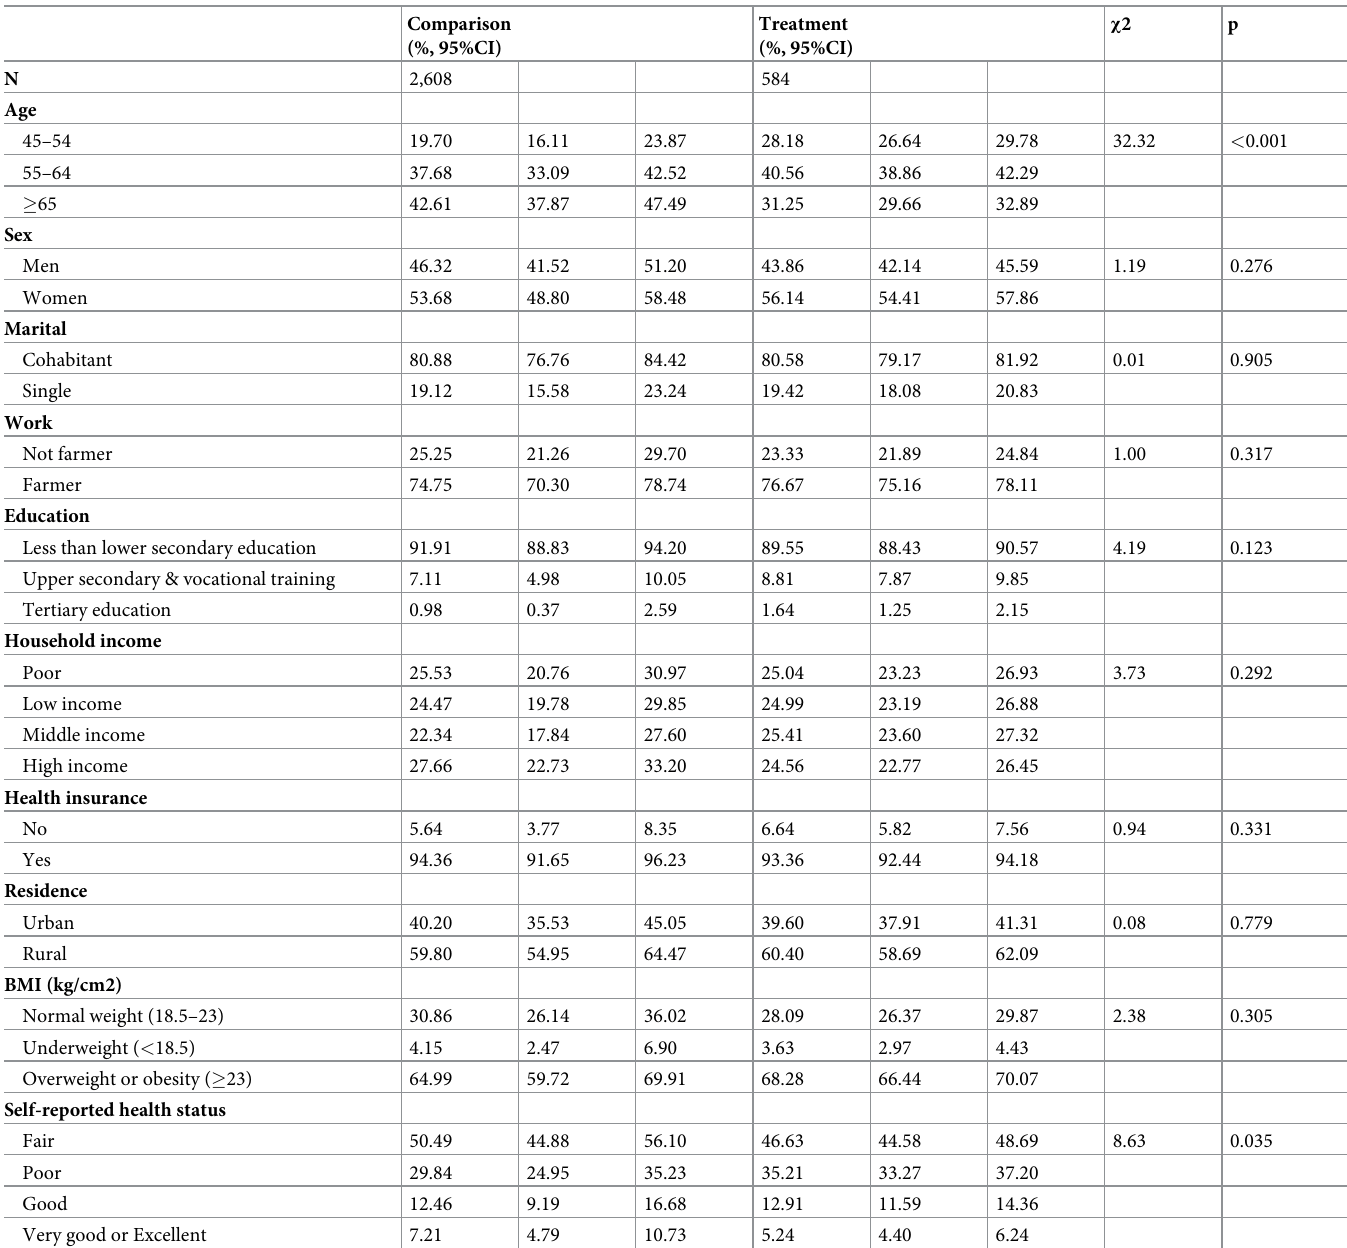
Table 1. Baseline characteristics of patients with hypertension (% 95%CI).